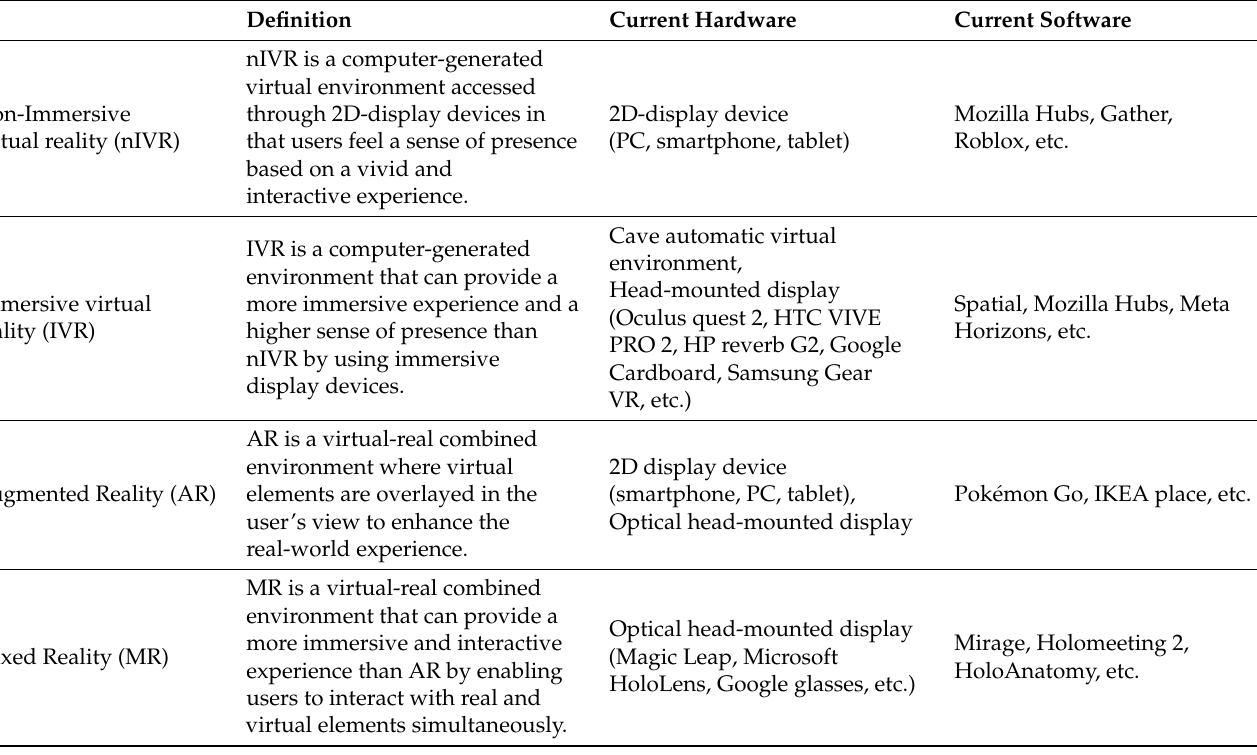
Table 1. Definitions of XR